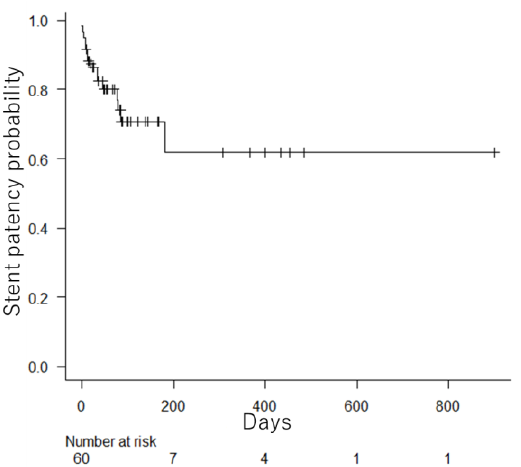
Figure 3. Time to RGOO (recurrent gastric outlet obstruction) after duodenal stenting. Less than half of the patients had RGOO; although there was no median, stent patency continued until death in many of those patients.